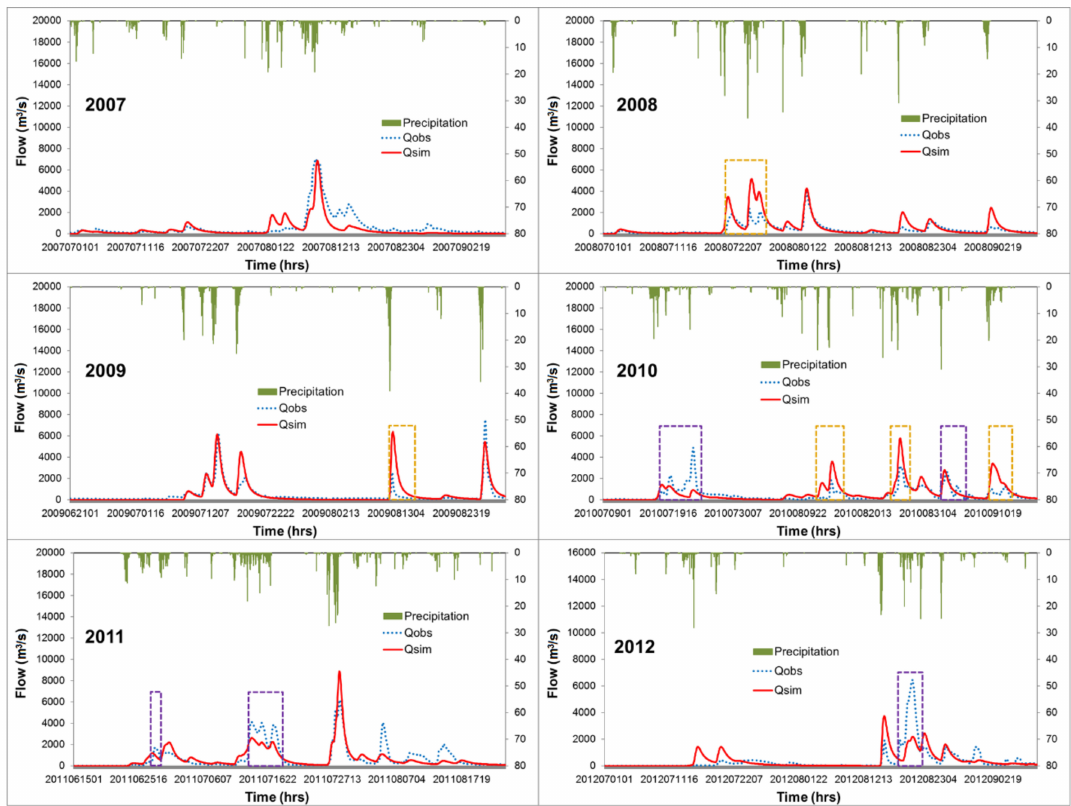
Figure 2. The simulated and observed discharges at Gunnam station in 6 flood events (2007, 2008, 2009, 2010, 2011, and 2012) without considering dam impact. The purple dotted line expresses the periods a ff ected by the dam releasing water, and the orange dotted line expresses the suppositional periods a ff ected by the dam storing water.